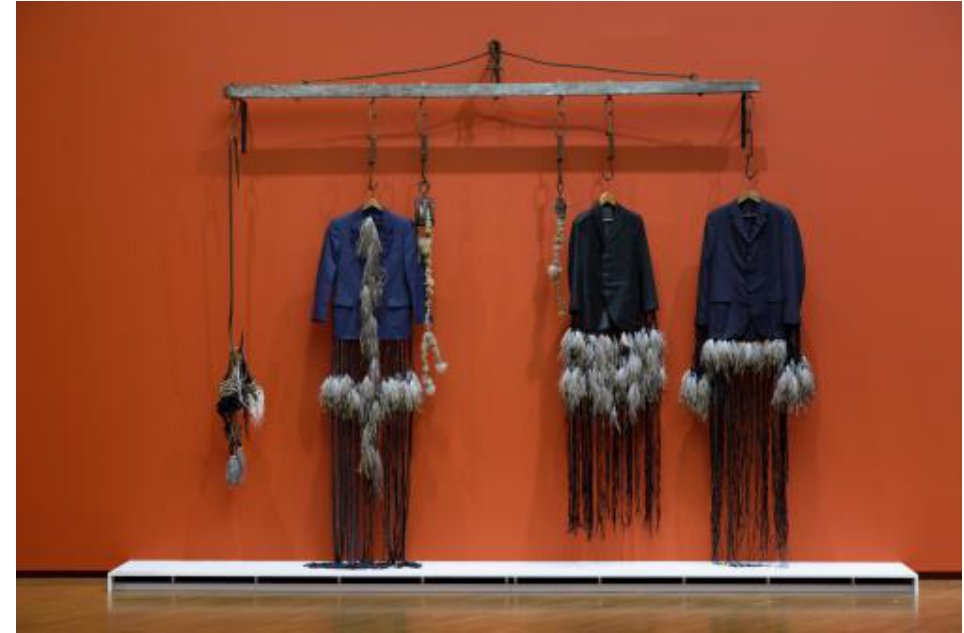
Karla Dickens, Assimilated Warriors II, 2014, emu feathers, textiles, leather, metal, wood. Installation view, Defying Empire: The Third National Indigenous Art Triennial, National Gallery of Australia, Canberra, ACT, photo courtesy of National Gallery of